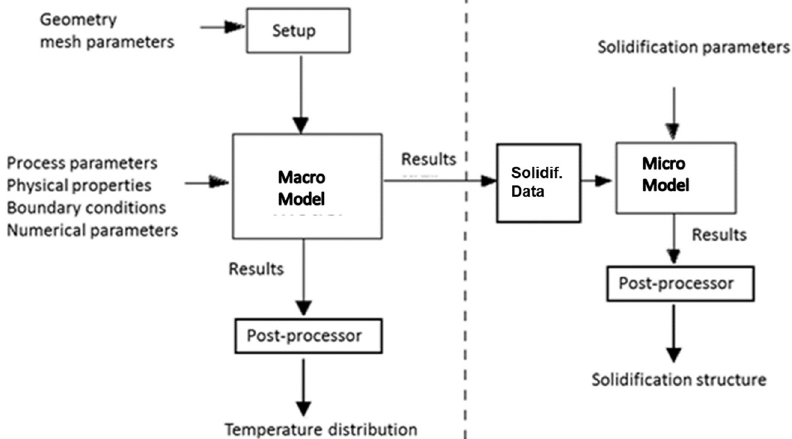
Figure 1. Diagram showing the coupling between the CFD macro-code and the solidification structure evolution stochastic mesoscopic code.